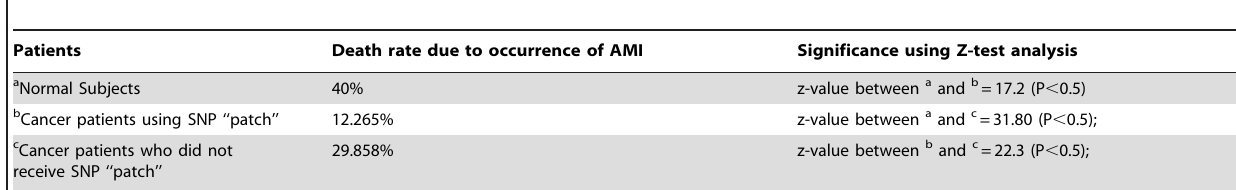
Table 3. Death rates due to acute myocardial infarction in cancer patients with and without the use of SNP ‘‘patch’’ and in the normal